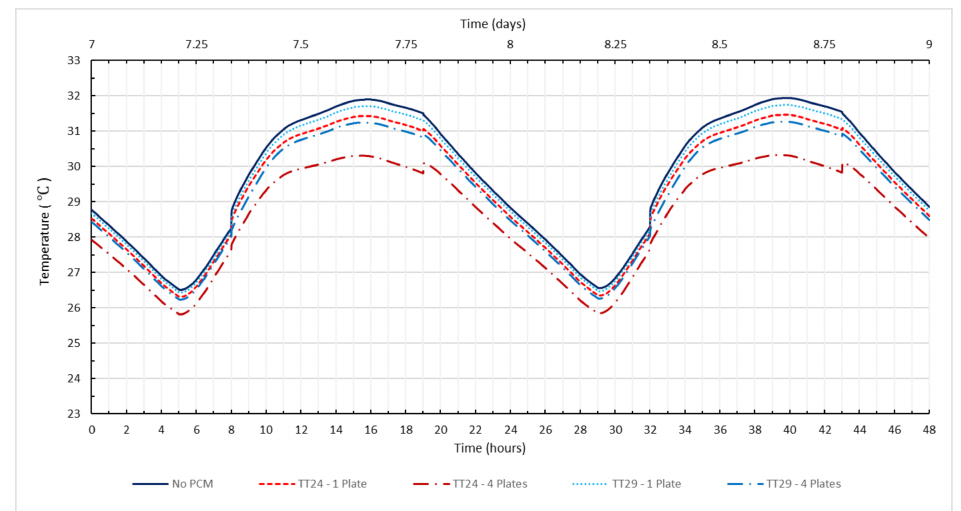
Figure 8. Indoor temperatures for the room with high thermal inertia, for the cases of no PCM, PCM with transition / melting temperature of 24 ◦ C, and transition / melting temperature at 29 ◦ C.